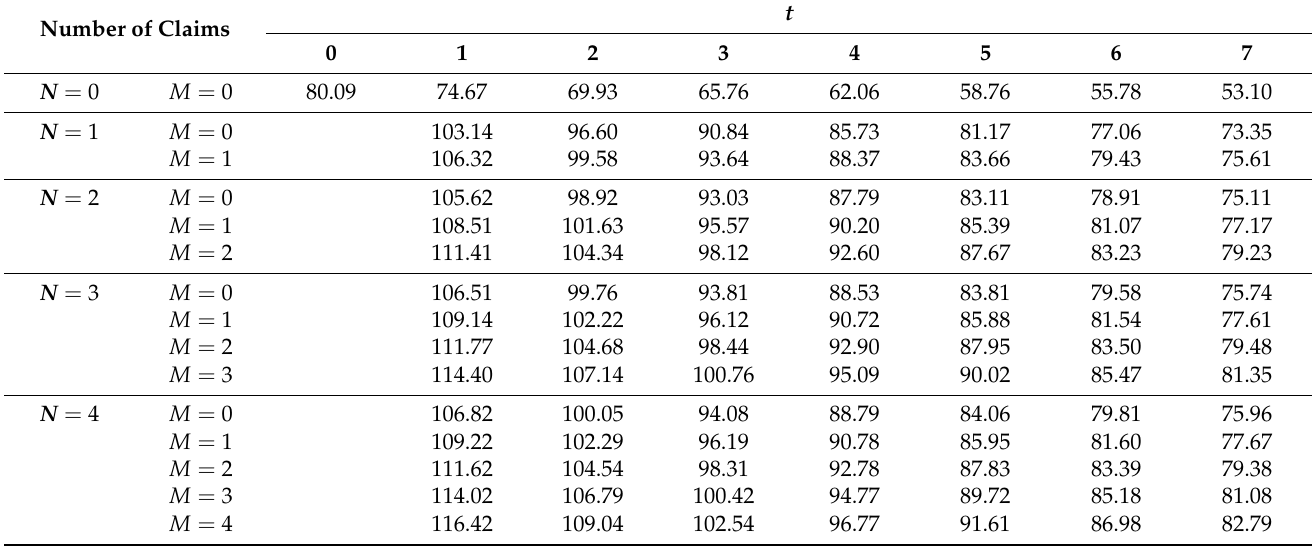
Table 8. Bonus-malus premiums based on Poisson binomial-exponential beta distribution for the frequency component and gamma-Lindley distribution for the severity component with a total claim size of S =